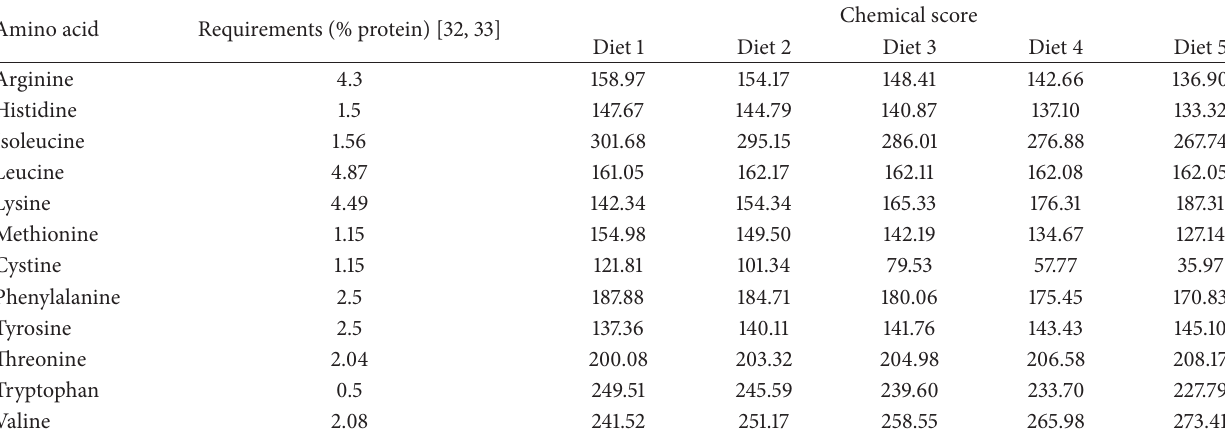
Table 3: Amino acid requirements and chemical score of prepared diets.